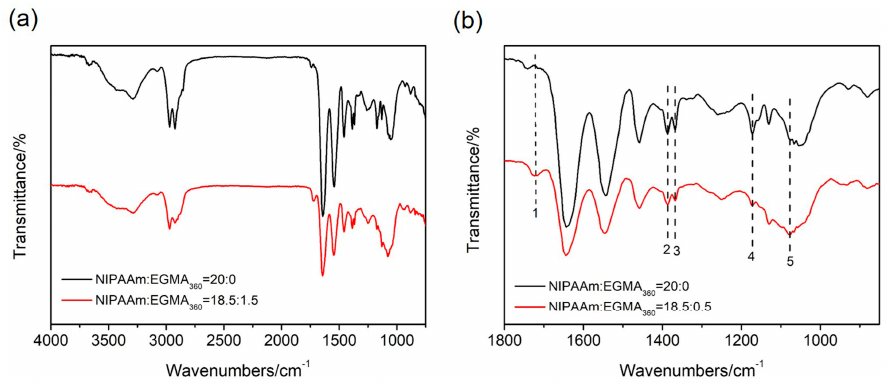
Figure 3. ( a ) ATR-FTIR spectra of alginate-Ca 2+ /P(NIPAAm- co -EGMA 360 ) hydrogel from 4000 to 600 cm − 1 . The monomer ratio of NIPAAm to EGMA 360 are 20:0 and 18.5:1.5. ( b ) Zoom-in the ATR-FTIR spectra ranging from 1800 to 850 cm − 1 .